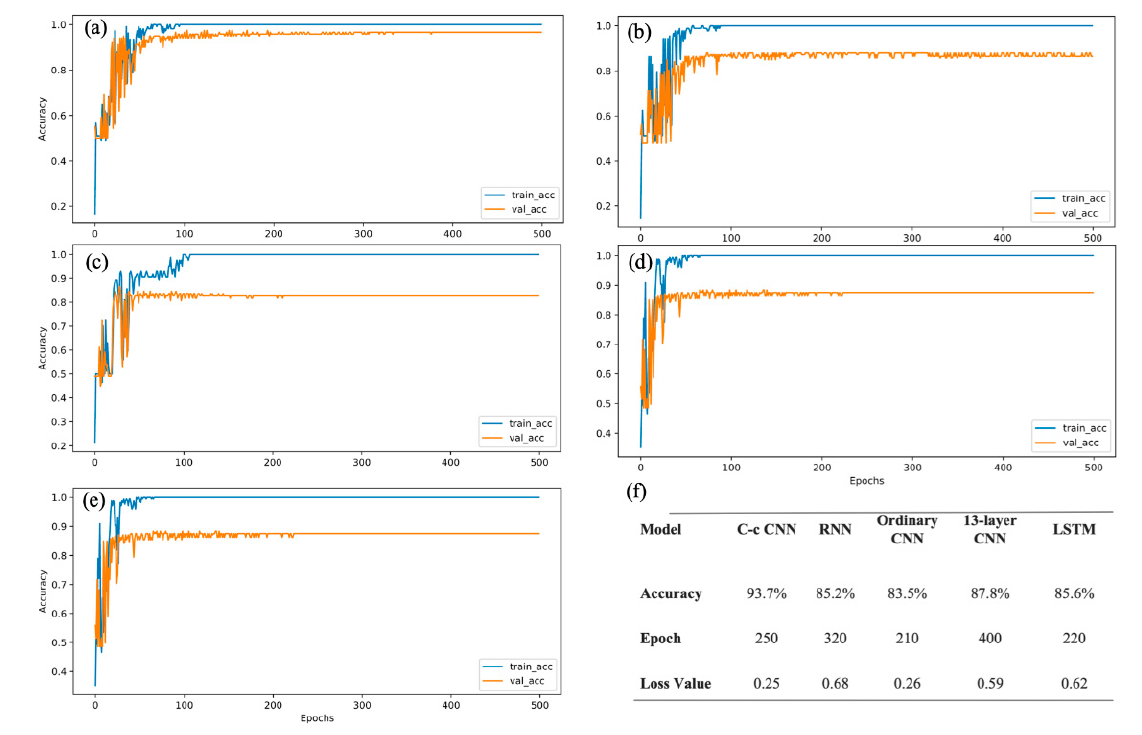
Figure 4. Results of Experiment 1 ( a ) C-c CNN; ( b ) RNN; ( c ) ordinary CNN; ( d ) 13-layer CNN; ( e ) LSTM; ( f ) accuracy of different classifiers.